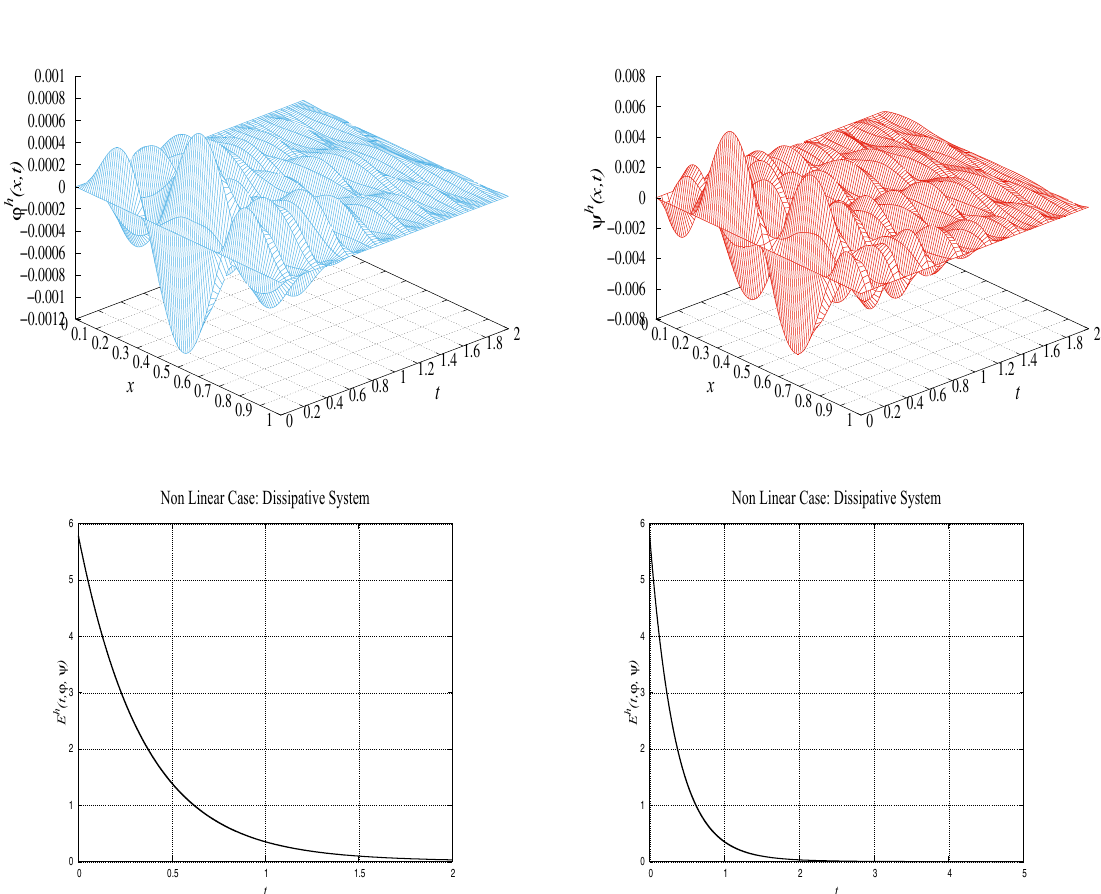
Fig. 2 Evolution of solutions: ϕ h ( x , t ), ψ h ( x , t ), respectively. Numerical Energy at time 2.0 s and 5.0 s,